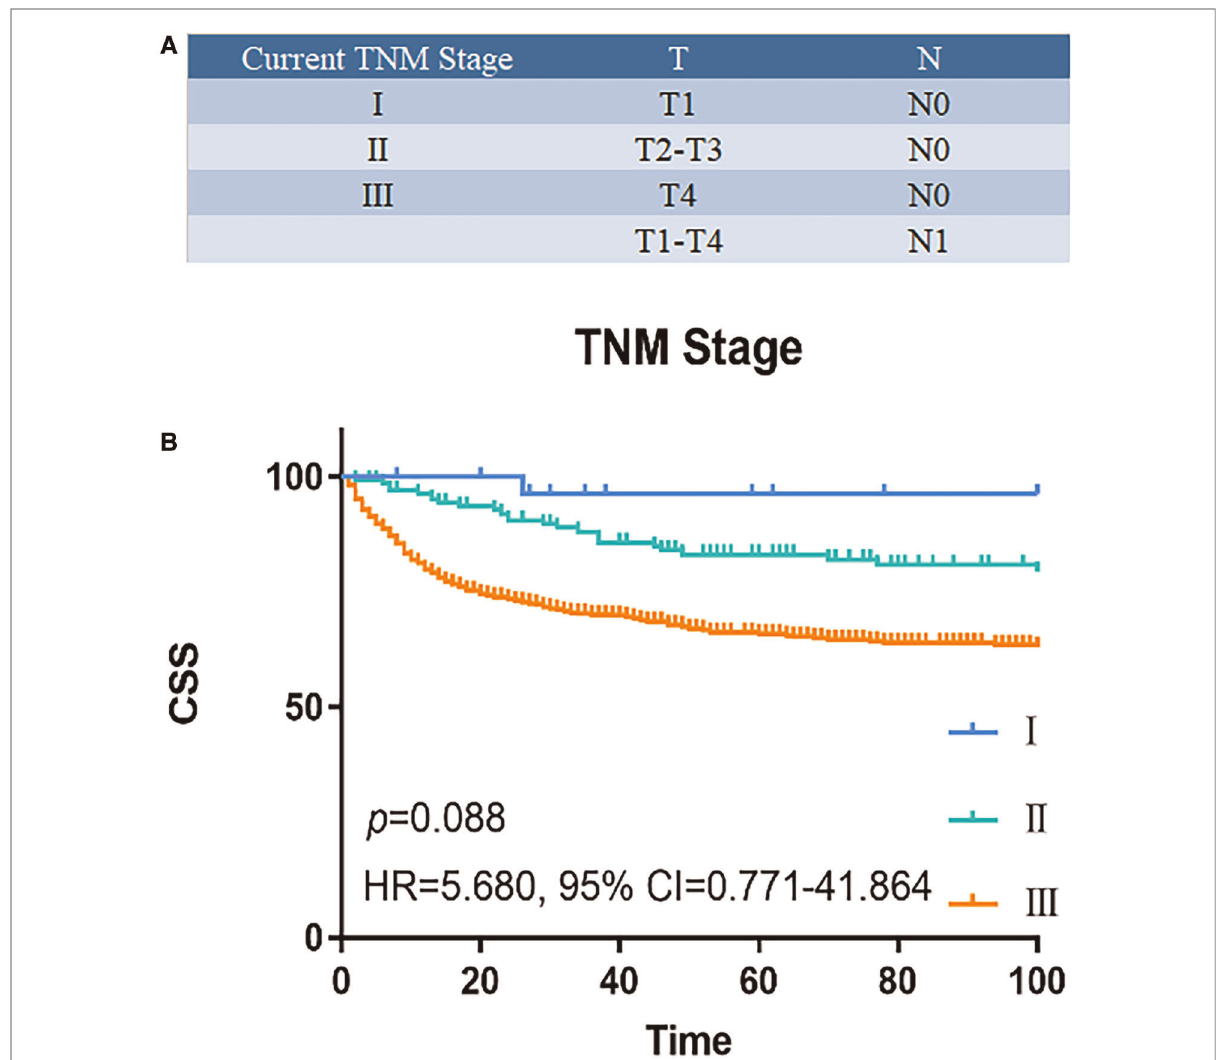
FIGURE 1 Survival analysis of current TNM staging system. ( A ) Current TNM staging system: I (T1N0M0), II (T2-3N0M0), III (T4N0M, TxN1M0), and IV (TxNxM1). ( B ) The CSS curve based on TNM staging system. The survival curves of stage I and II patients overlapped (HR, 5.680, 95% CI, 0.771 – 41.864, p = 0.088). P values are derived from the Cox risk model. CSS, cancer-speci fi c survival; TNM, tumor – lymph node – metastasis; HR, hazard ratio; CI, con fi dence